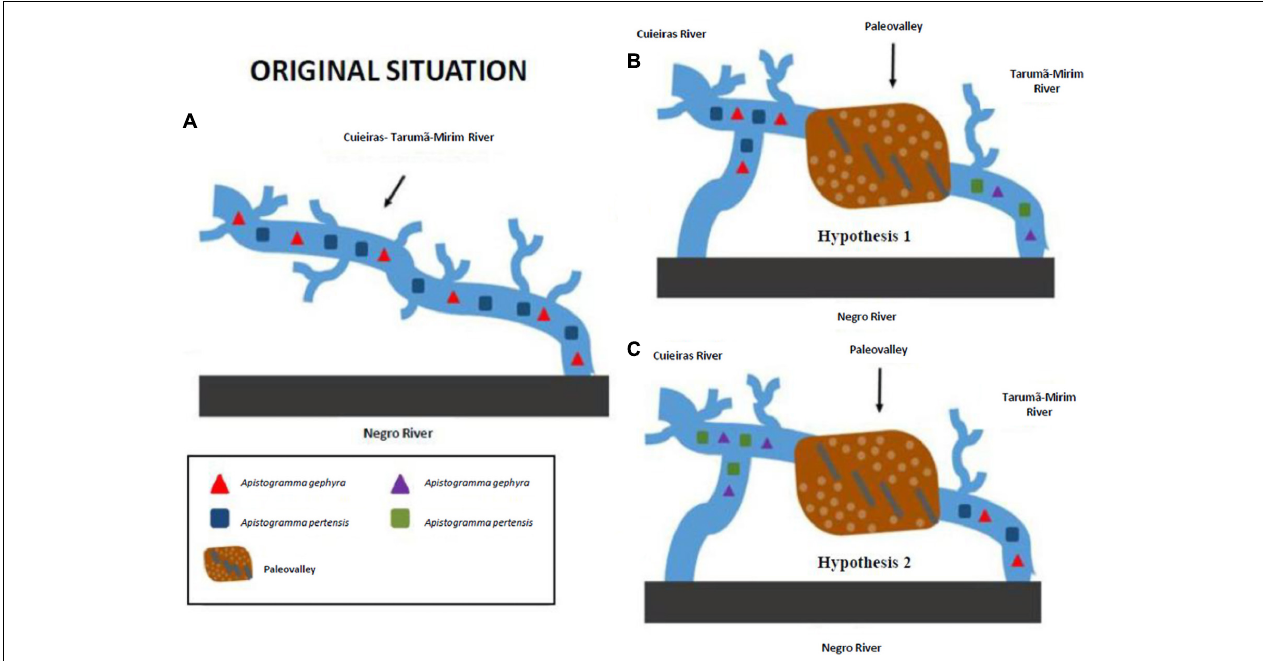
FIGURE 4 | Hypothetical scenarios. The hypothetical scenarios are delineated to propose an explanation for the strong genetic structure observed between the populations of Apistogramma gephyra and Apistogramma pertensis in the two rivers (Cuieiras and Tarumã-Mirim): (A) A. gephyra and A. pertensis populations from the Tarumã-Mirim River differentiated after the geographic isolation, with the lower Tarumã-Mirim River region being influenced by populations from the lower Negro River; and/or (B,C) the landscape changes in the course of the Cuieiras River and provided a wide area of distribution and allowed some gene flow between the species, thus adding more complexity to the differentiation between populations, with potential influences from individuals of the Anavilhanas populations just west of the mouth of the Cuieiras River.